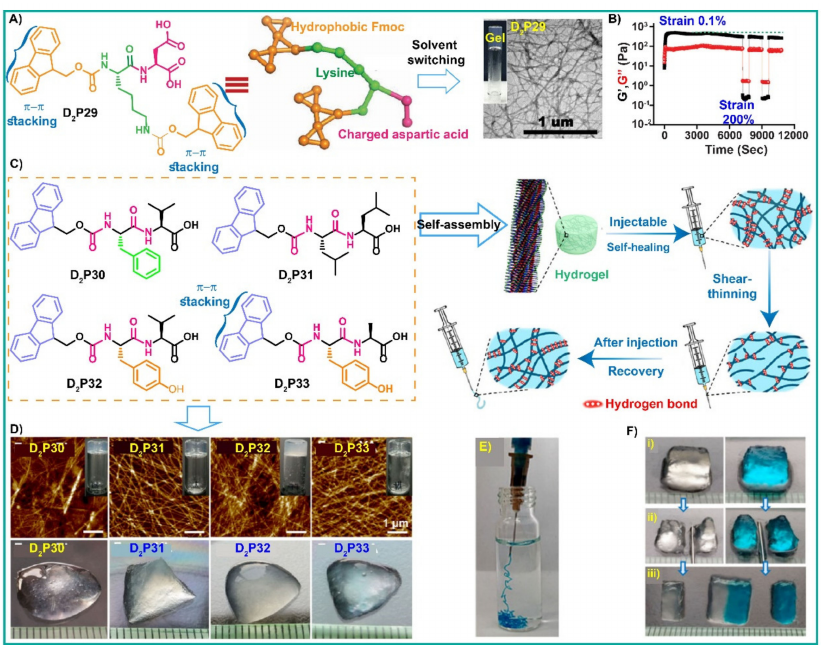
Figure 5. ( A ) Chemical structure and TEM image of the dipeptide hydrogelator (D 2 P29). ( B ) Thixotropy test of D 2 P29 hydrogel; reproduced with permission from Ref. [83]. Copyright (2020). John Wiley and Sons. ( C ) Molecular structures and schematic representation of the dipeptide gelators (D 2 P30-D 2 P33) for the self-thinning and self-healing behavior. ( D ) AFM images and photographs of 26-gauge needles injected into dipeptide hydrogels. ( E ) Injectability behavior of methylene blue- stained hydrogel (D 2 P32). ( F ) Self-healing behavior of D 2 P32 hydrogel; reproduced with permission from Ref. [84] Copyright (2020) American Chemical